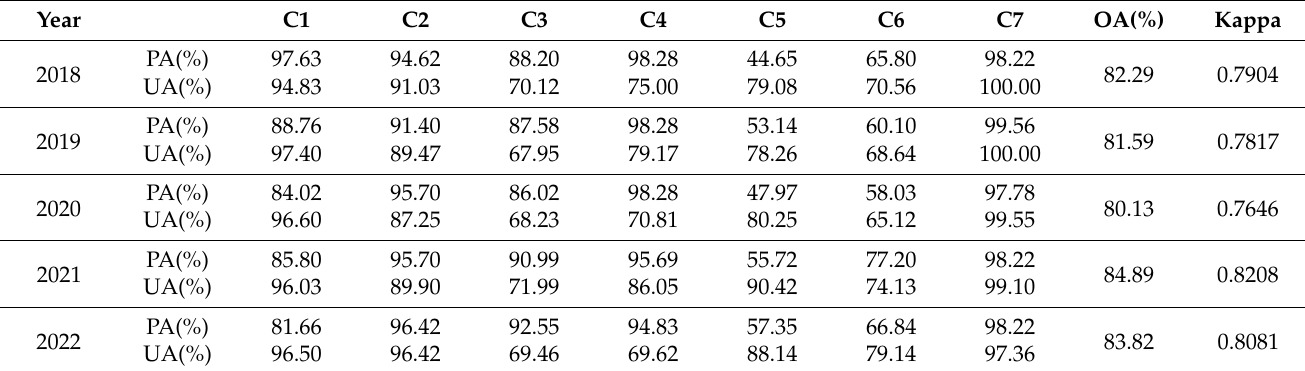
Table 3. Accuracy evaluation results based on testing